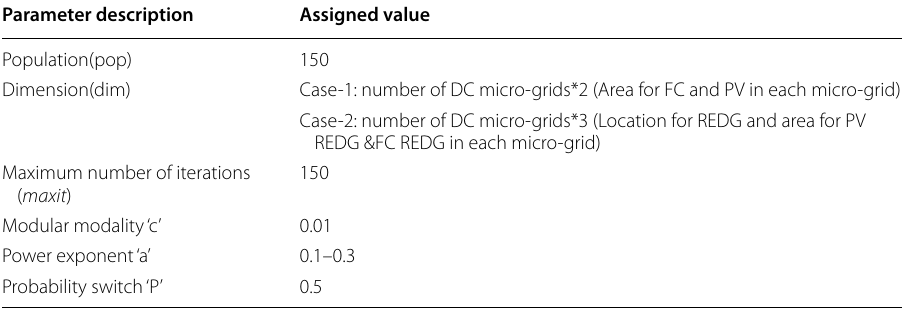
Table 1 Parameters description of BO algorithm Parameter description